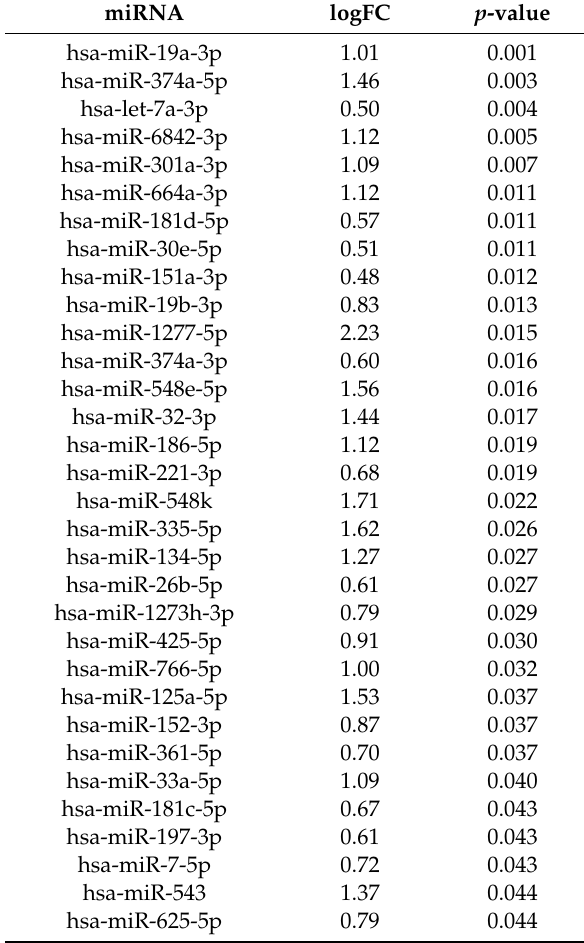
Table 1. In total, 32 of 322 miRNAs showed a significant change upon anti-CD3 stimulation in next-generation sequencing. Raw read counts were used in EdgeR to identify microRNAs di ff erentially expressed in extracellular vesicles derived from PBMCs treated with anti-CD3 versus Isotype control. miRNA logFC p